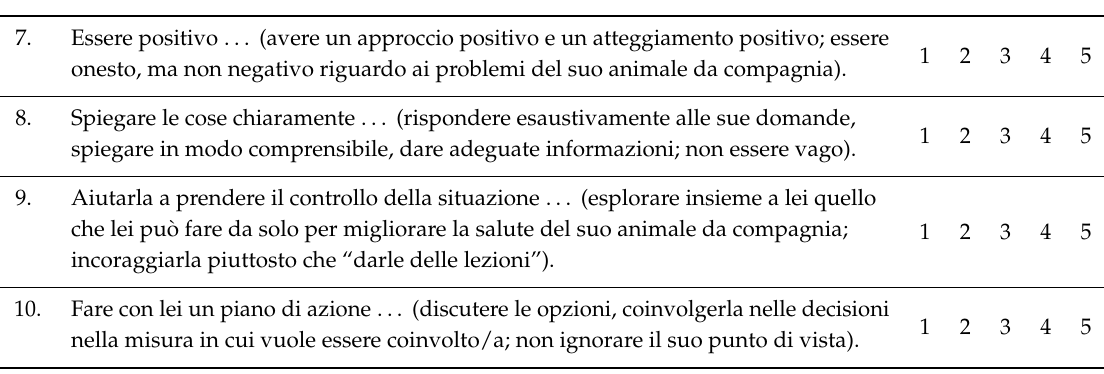
Essere positivo . . . (avere un approccio positivo e un atteggiamento positivo; essere